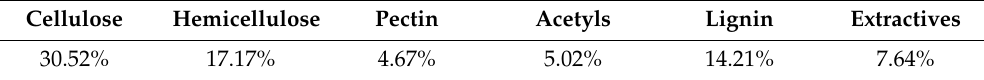
Table 2. Raw material chemical composition.